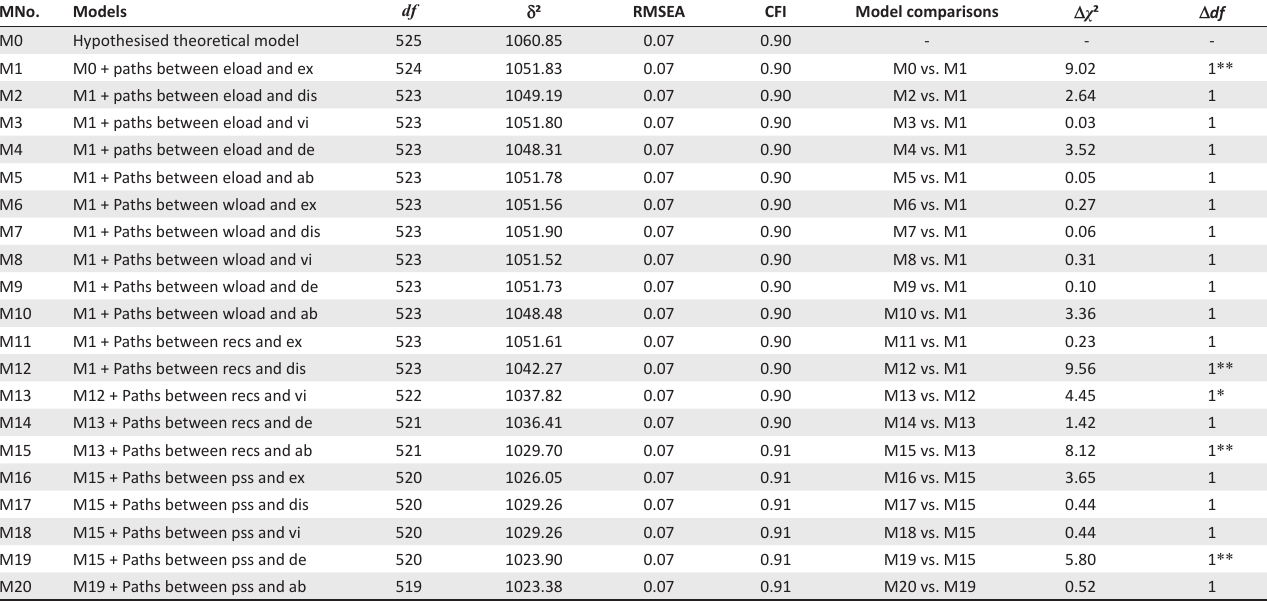
TABLE 3: Fit indices for structural models ( N = 226).